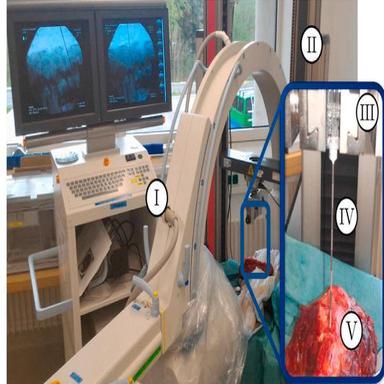
Measurement setup for needle insertion force measurements (I: C-arm with workstation, II: material testbench, III: needle clamping device attached to load cell, IV: 18-gauge Tuohy needle, V: human specimen).